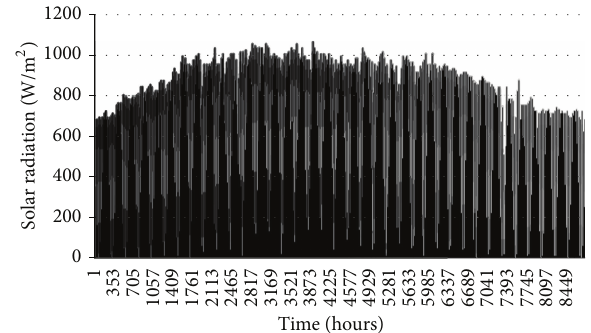
Figure 1: Typical PV system components.